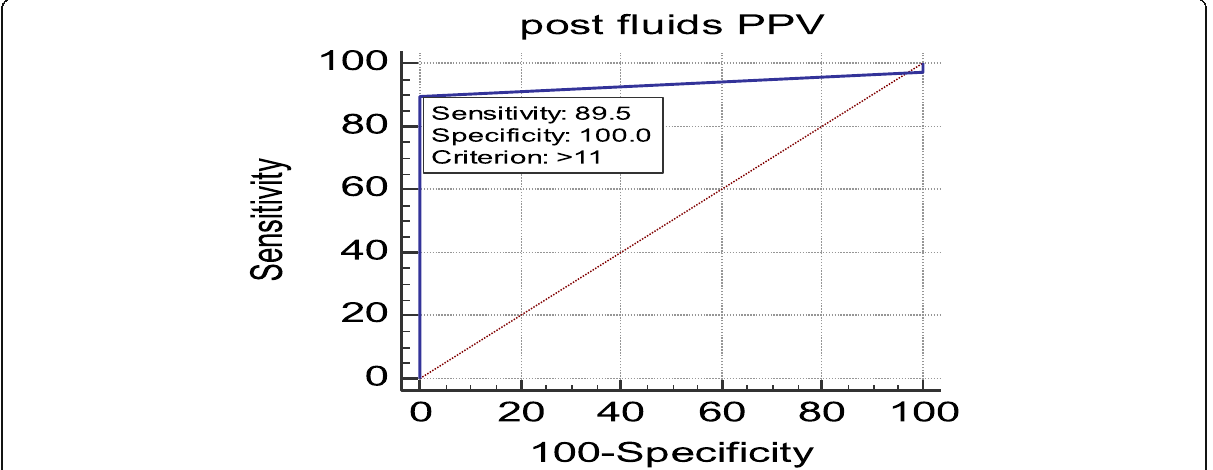
Fig. 3 Receiver operating characteristic (ROC) analysis of PPV after fluid bolus. Pulse pressure variation (PVI) is considered as a predictor of an increase in cardiac output (CO) after fluid bolus during periods of